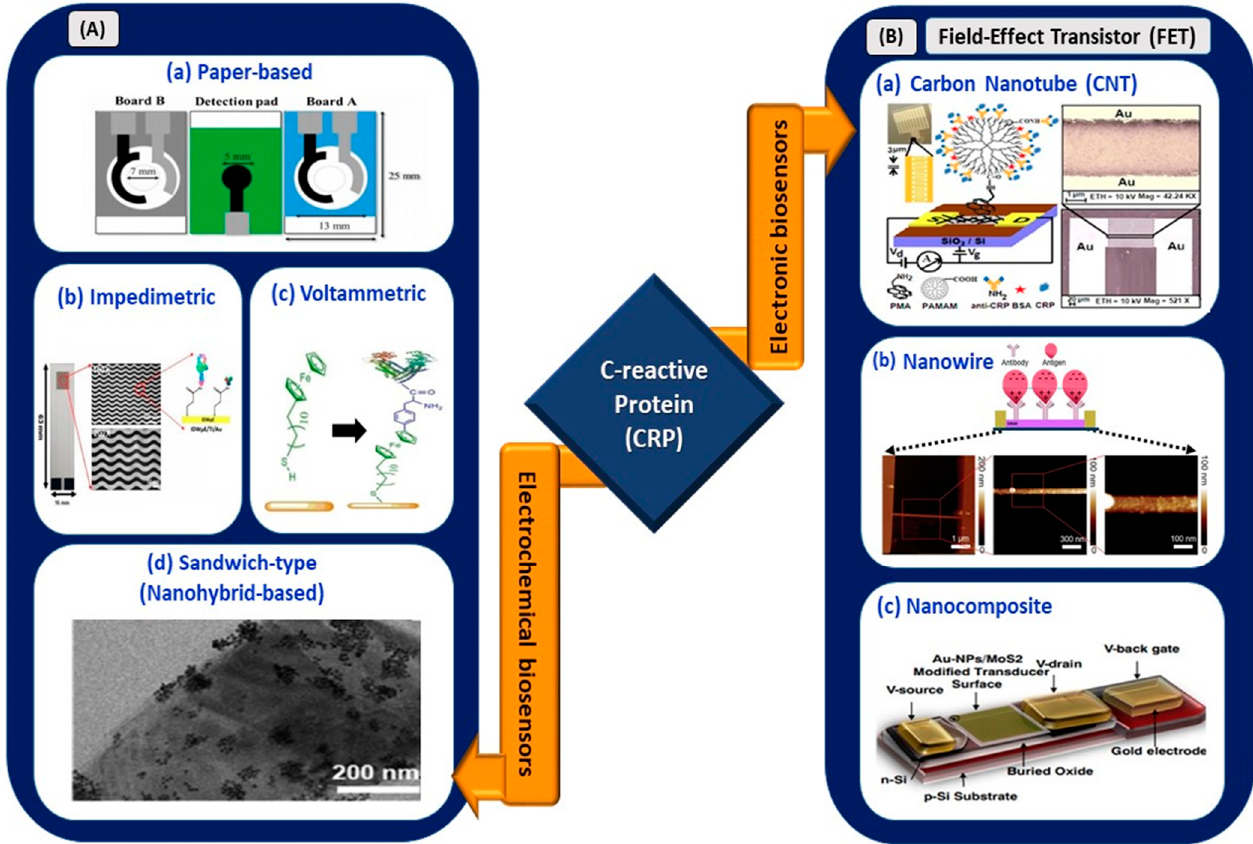
Figure 4. ( A ) Electrochemical biosensors: ( a ) origami paper-based sensing of CRP (reprinted with permission from [59]), ( b ) interdigitated wave-shaped microelectrode-based impedimetric sensor (reprinted from [60]), ( c ) electrochemical sensing of CRP with ferrocene thiol-coated gold electrode (reprinted from [61]), and ( d ) sandwich-type sensor with nanohybrid materials for CRP detection (reproduced from [62]). ( B ) Electronic biosensors: ( a ) PAMAM-modified CNT-based FET (reprinted with permission from [63]), ( b ) nanowire-based FET (reprinted from [64]), and ( c ) nanocomposite-based FET for CRP detection (reprinted with permission from